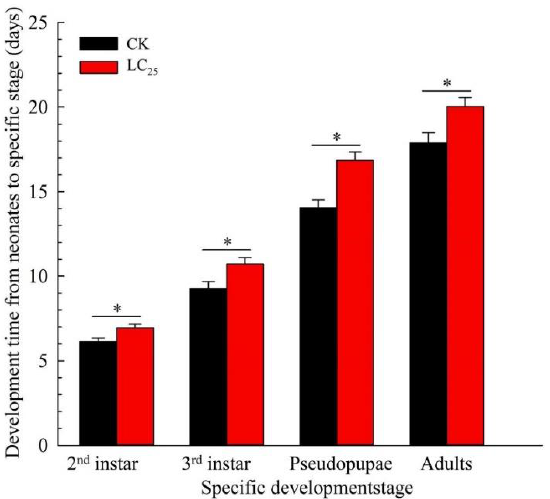
Figure 1. Development times for the F 1 generations of B. tabaci in CK and LC 25 treatment groups. Values are presented as means ± SE. Asterisks above error bars indicate significant differences ( p < 0.05).